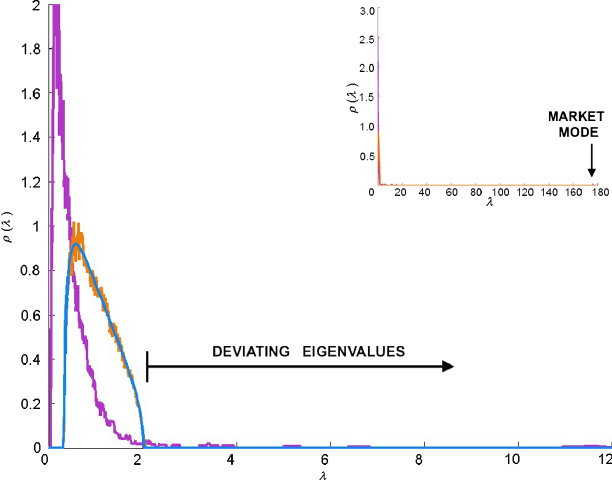
FIG. 1. The eigenvalue density of the empirical correlation matrix of T ¼ 2500 log-returns (of daily closing prices from 2001Q4 to 2011Q3) for N ¼ 445 stocks of the S&P 500 index (purple) and the Marcenko-Pastur prediction for a random correlation matrix with the same values of N and T (blue), denoting a maximum expected eigenvalue of approximately 2. The orange plot is the eigenvalue density obtained by randomly shuffling (i.e., permuting with uniform probability) the empirical increments within each of the observed time series, confirming the agreement with random matrix theory for uncorrelated data. The inset is the fully zoomed-out version of the plot, showing that the empirical correlation matrix has a maximum eigenvalue of about 175 ( “ market mode ” ), as well as a handful of other leading eigenvalues above the predicted maximum